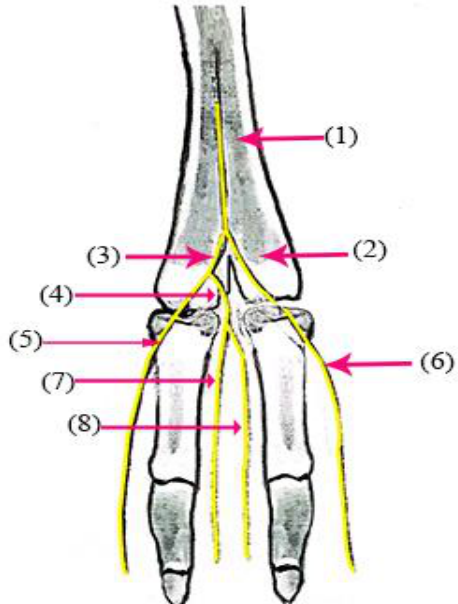
Figure 3. Nerve supply of the dorsal surface of the distal hindlimb in camels: (1) superficial fibular nerve; (2) common dorsal nerve of the IV digit; (3) common dorsal nerve of the III digit; (4) axial dorsal proper nerve of the III digit; (5) abaxial dorsal proper nerve of the III digit; (6) abaxial dorsal proper nerve of the IV digit; (7) axial dorsal proper nerve of the III digit; (8) axial dorsal proper nerve of the IV digit.